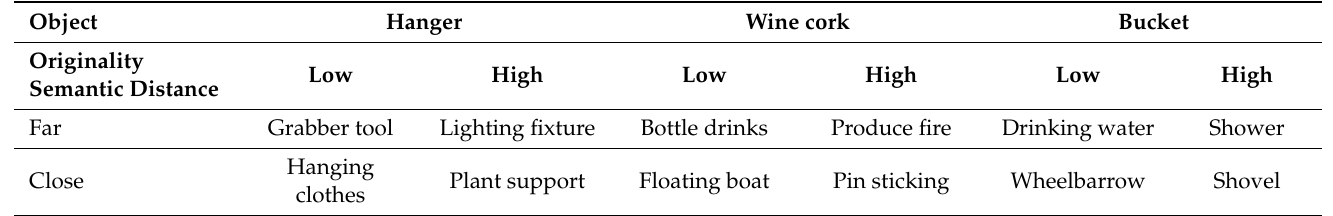
Table 2. The examples used for instruction manipulations of originality (low, high) and distance (far,